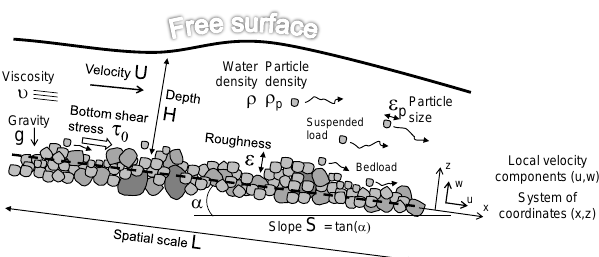
Figure 1. Quantities most often used in the literature of free-surface flow and morphodynamic modelling, with explicit reference to the ( L , T , H ) spatiotemporal scales of interest. This review is limited to 1-D ( x ) spatial representations for simplicity, focusing on the streamwise ( x ) component of the mass and momentum conserva- tion equations. The streamwise length ( L ) and velocity ( U ) suggest a natural timescale T 0 = L/U for the propagation of information, waves, or perturbations, to be compared with the timescales ( T ) opted for in the